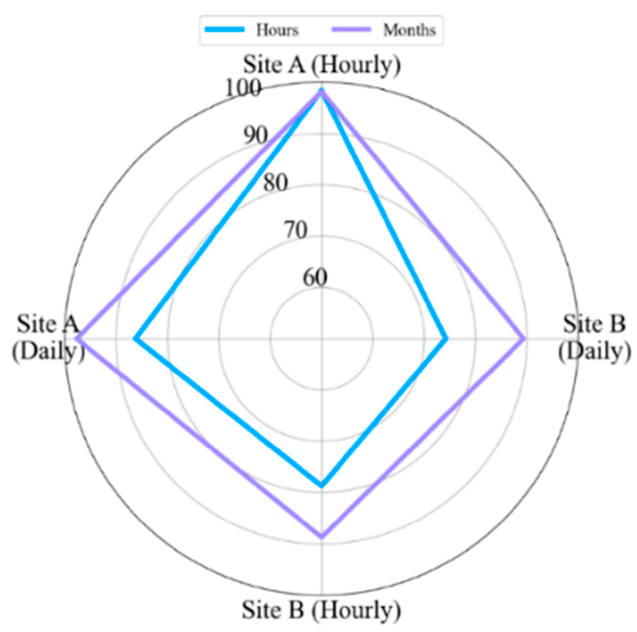
Figure 10. Comparison of seasonal partition.